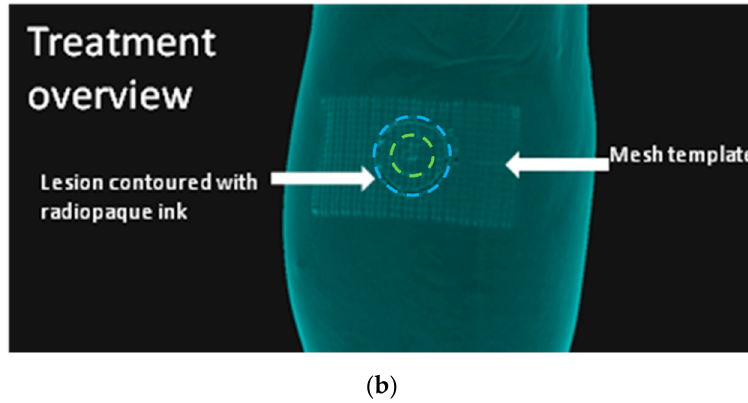
Figure 7. ( a ) GTV contouring is shown in green, with its enlargement to a 6 mm CTV shown in blue. ( b ) Three-dmensional rendering of the radio-opaque template with details of lesion GTV, CTV, and mesh template.